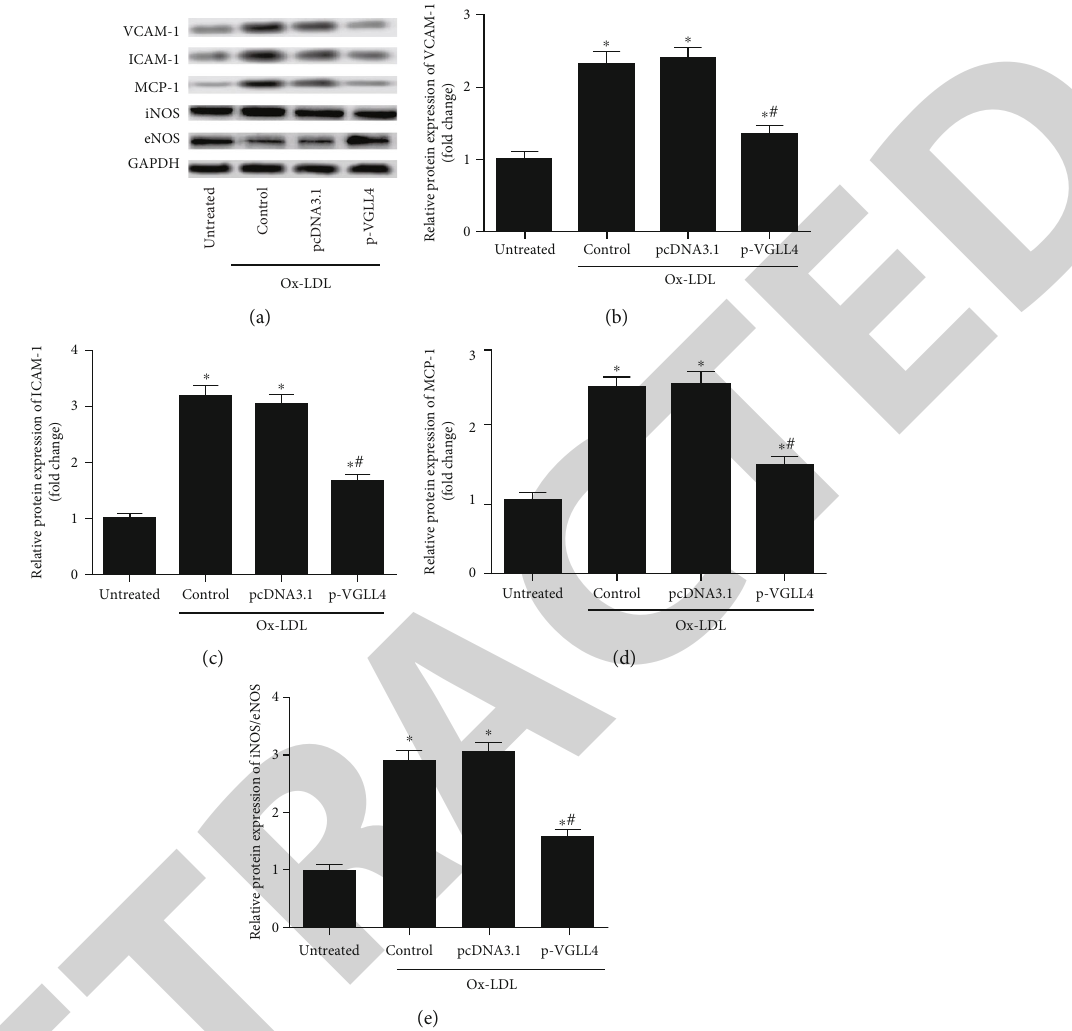
Figure 4: Overexpression of VGLL4 alleviates Ox-LDL-induced dysfunction in HUVECs. The HUVECs were treated with Ox-LDL (100 μ g/mL) and transfected with the control vector (pcDNA3.1 group) or pcDNA3.1-VGLL4 (p-VGLL4 group), respectively. (a) Western blot was performed to con fi rm the protein expression levels of VCAM-1, ICAM-1, MCP-1, iNOS, and eNOS. (b – d) The protein expression of VCAM-1, ICAM-1, and MCP-1 in the untreated, control, pcDNA3.1, and p-VGLL4 groups. (e) The protein expression of NOS and eNOS in the untreated, control, pcDNA3.1, and p-VGLL4 groups. “ ∗ ” means compared with the untreated group at P < 0 : 05 , and “ # ” means compared with the pcDNA3.1 group at P < 0 : 05 . GAPDH was used as an invariant internal control for calculating protein fold